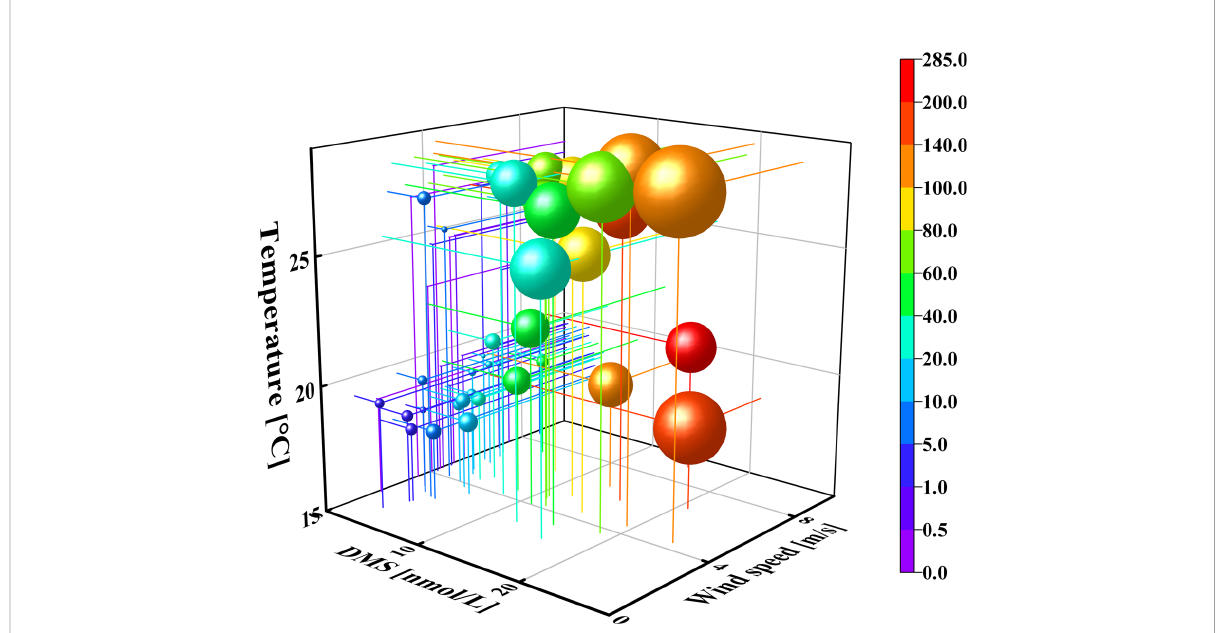
FIGURE 8 Space diagram of DMS concentration – wind speed (WS) – temperature (T) – air-to-sea fl ux in the surface waters of BS and NYS in summer and autumn. The sizes and colors of the balls represent the concentrations of DMS and air-to-sea fl uxes, respectively. The color of the balls represent the fl ux